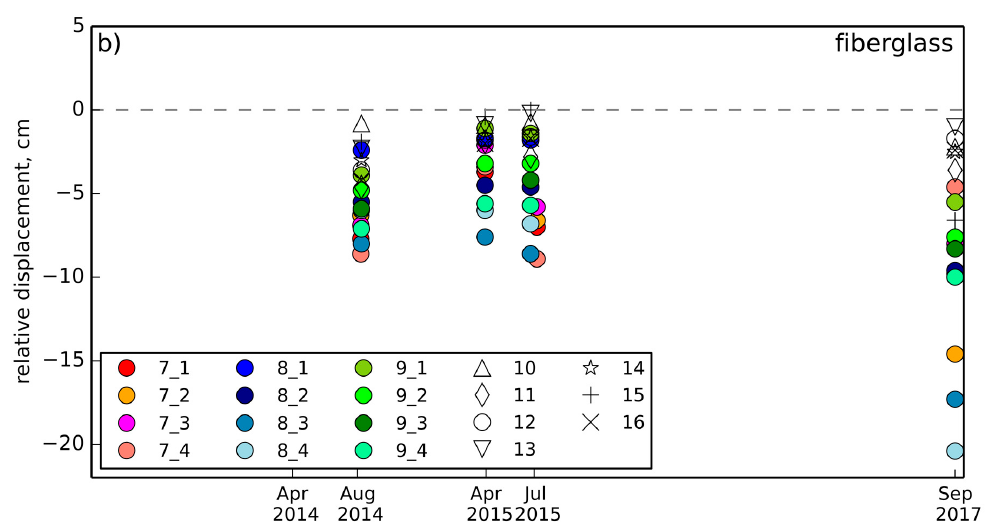
Figure 4. ( a ) Seasonal and interannual displacement measured from 2013 to 2017 with metal pipes (each circle marks a station). Displacement is relative to the initial level in April 2013. The three larger circles represent stations 7, 8, and 9, located in the thermokarst basins. Note that in summer 2013 some stations were not measured at the end of August; ( b ) seasonal and interannual subsidence measured from 2014 to 2017 with fiberglass rods. Displacement is relative to the initial level in April 2014. Note that all displacements are shown relative to the April 2013 ( a ) or April 2014 ( b ) reference level.